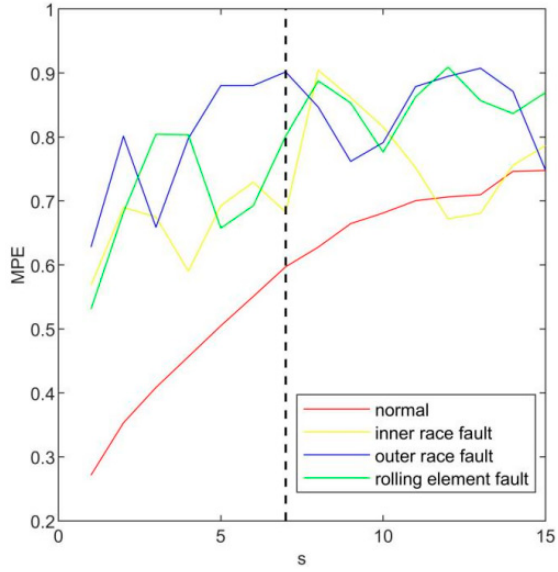
Figure 7. The MPE of imf1.